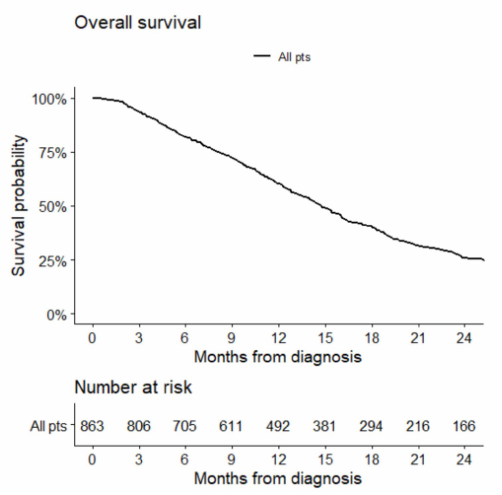
Figure 2. Overall survival of glioblastoma patients with assessment of MGMT promoter methylation status by PSQ approach.